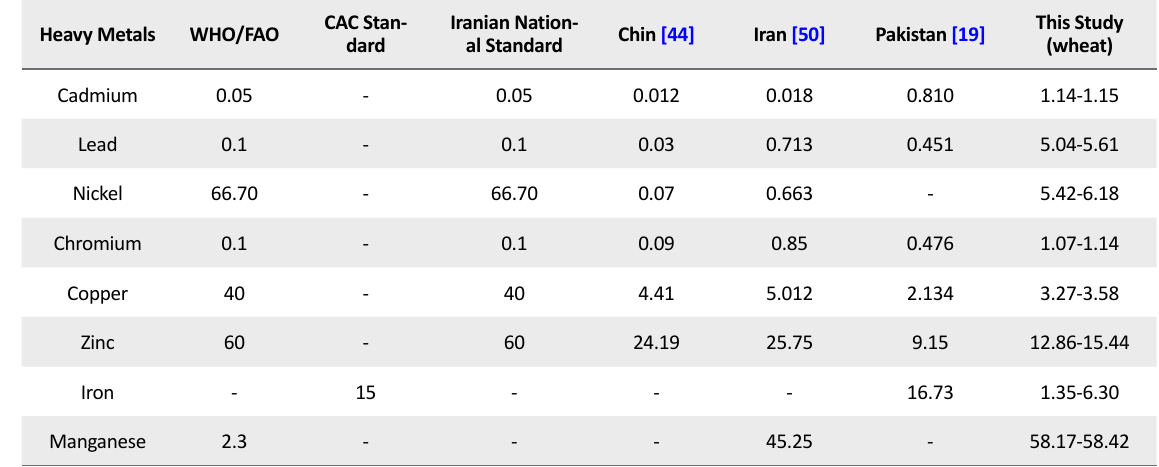
Table 9. Comparison of heavy metal concentrations in the wheat samples with international standards [45-49] Heavy